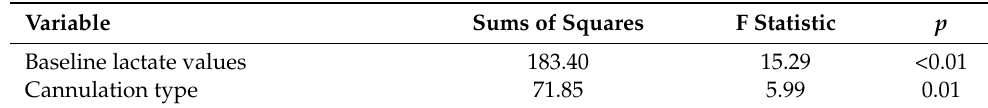
Table 5. Analysis of covariance of lactate values in the ICU.